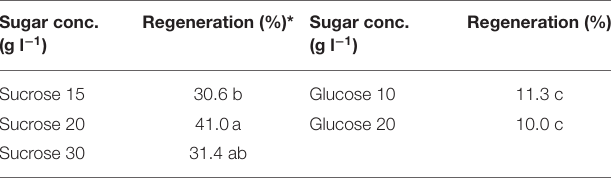
TABLE 5 | Effect of C-sources in shoot regeneration medium (SRM) on protoplast regeneration of rapeseed. Sugar conc. (g l − 1 )